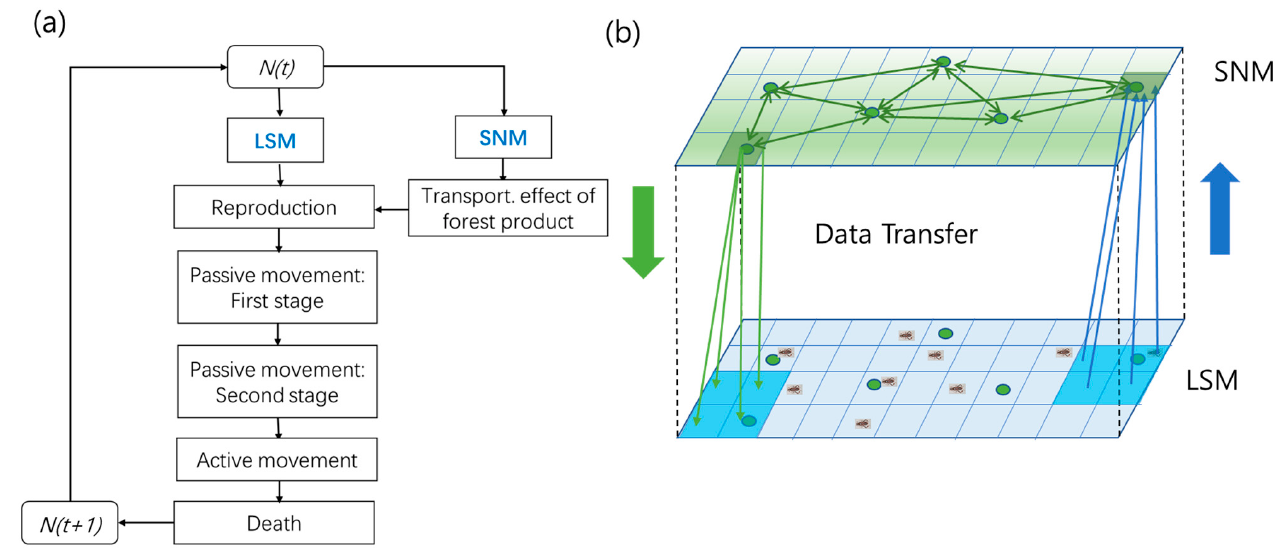
Figure 4. Incorporating lattice-structured model (LSM) and spatial network model (SNM) into simulating population dispersal of the WCSB: flow chart ( a ), and linkage graph of two models (green dots presenting imaginary positions of local areas, and blue and green arrows indicating data transfer from LSM to SNM and vice versa, respectively) ( b ).